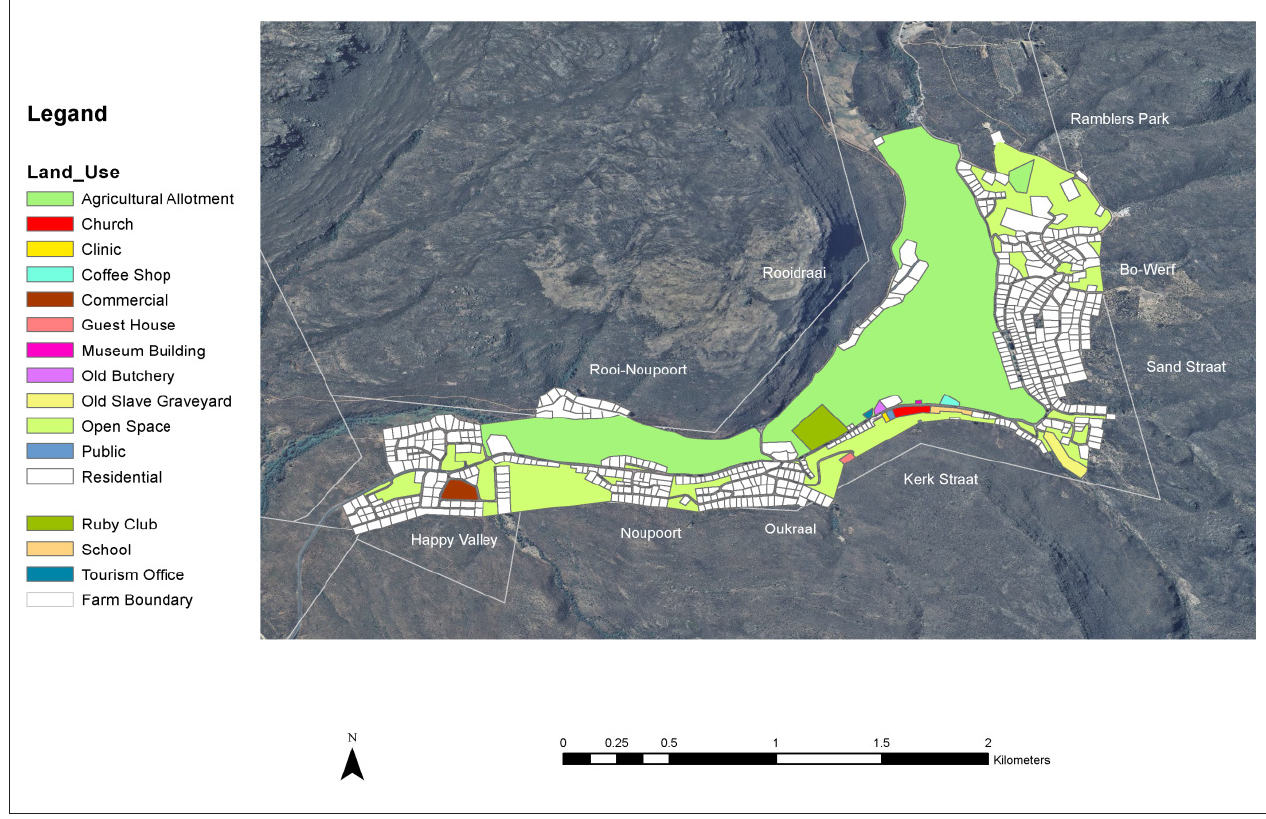
Figure 6: Goedverwacht mapped by CPUT students together with Goedverwacht residents (2015 to 2017). Source: Student Reports, 2017